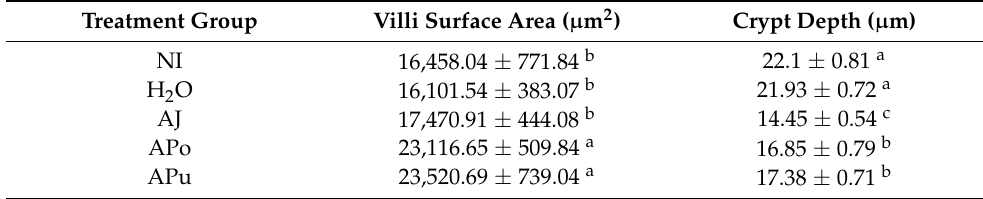
Table 4. Effect of the intra-amniotic administration of apple fraction soluble extracts on villi surface area and crypt depth.